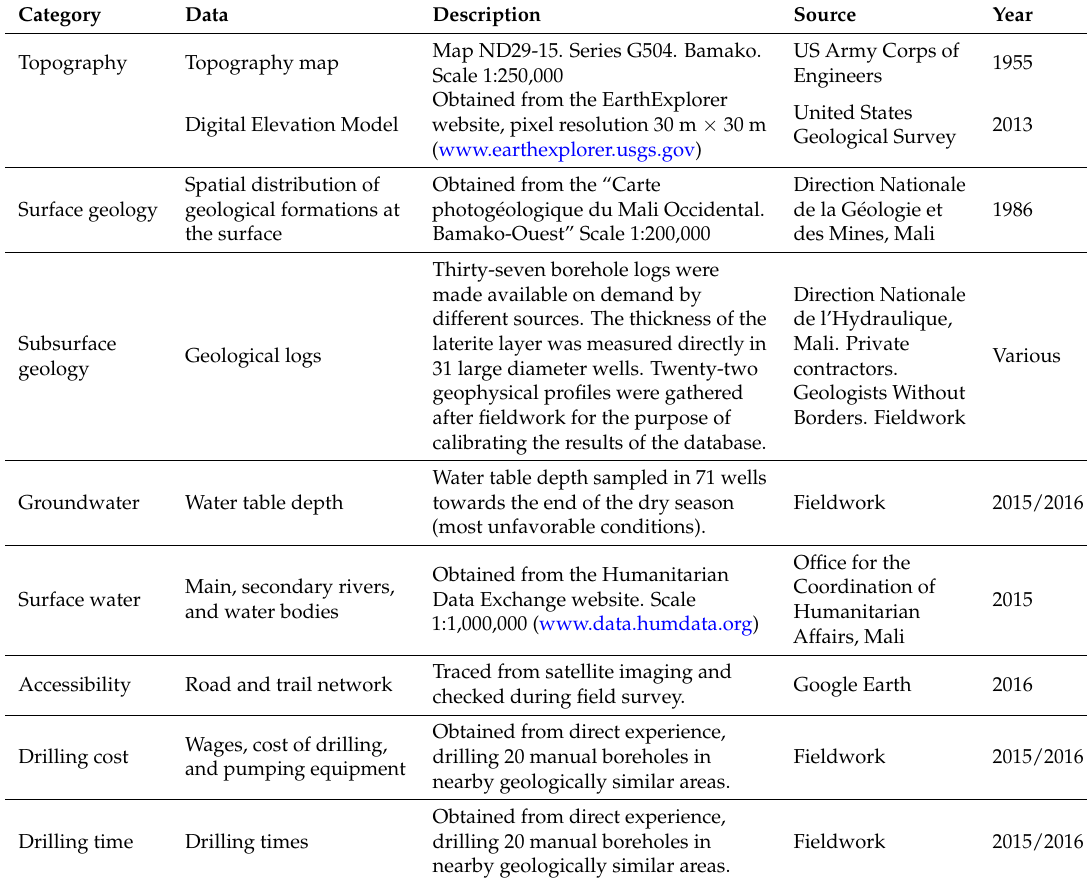
Table 2. Data requirements, resolution, reliability, and